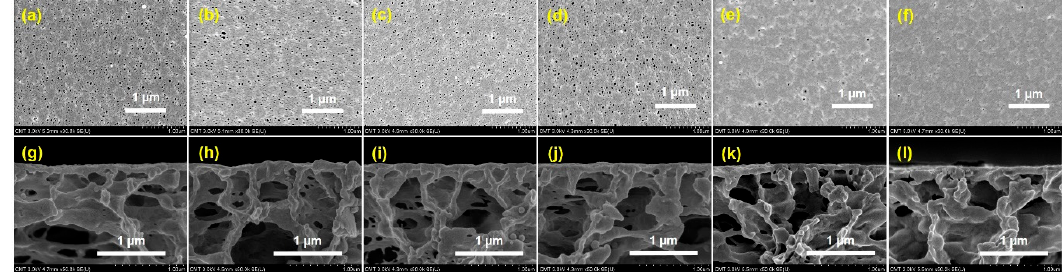
Figure 2. SEM images of surface and cross-section morphology for ( a , g ) PVDF, ( b , h ) PVDF-PSBMA 30s , ( c , i ) PVDF-PSBMA 60s , ( d , j ) PVDF-PSBM 120s , ( e , k ) PVDF-PSBMA 180s , and ( f , l ) PVDF-PSBMA 300s .